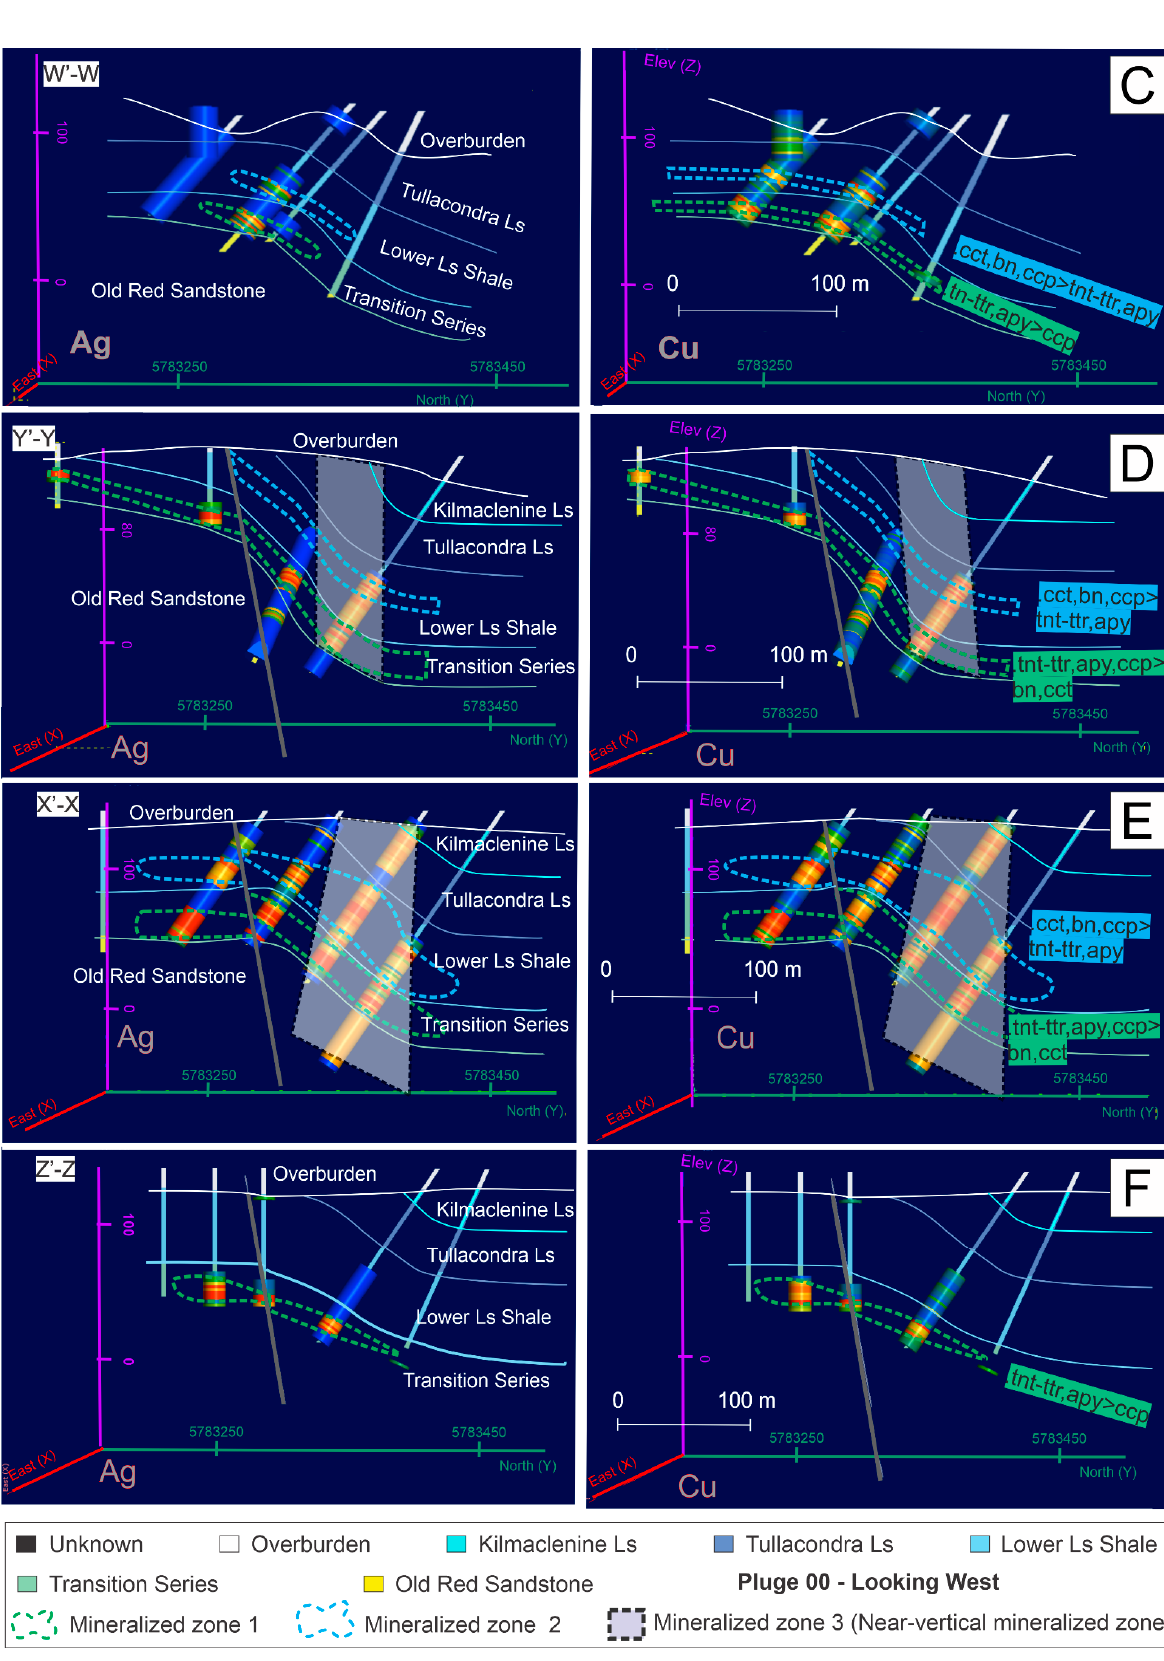
Figure 4. Spatial distribution of core logging, faults, Ag ( A ), and Cu ( B ) assay data. Figure 4C–F are cross-sections of the Tullacondra deposit (looking west) showing the localization of the Cu (>0.2%) and Ag (>14 ppm) mineralization